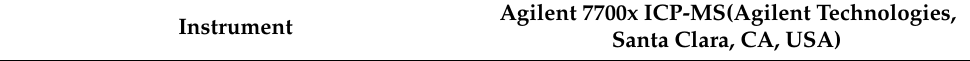
Table 2. Analytical conditions of ICP-MS.